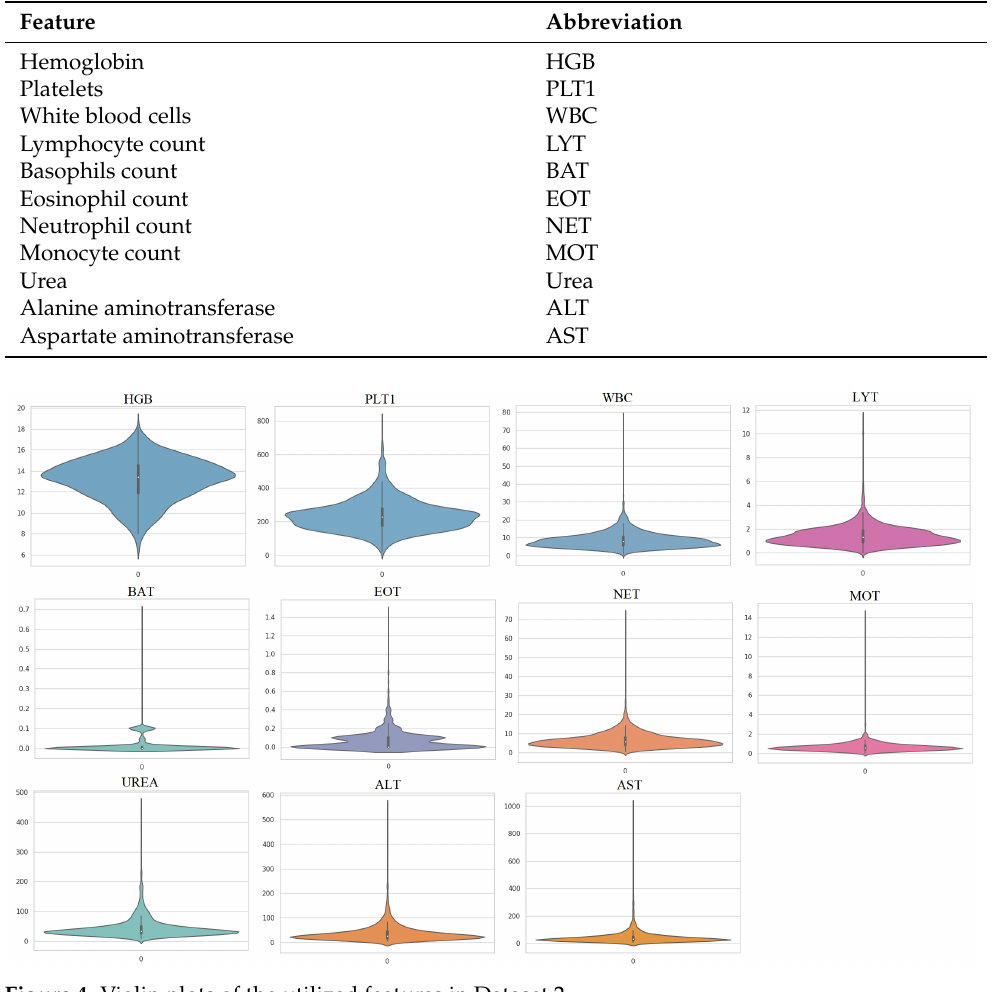
Figure 4. Violin plots of the utilized features in Dataset